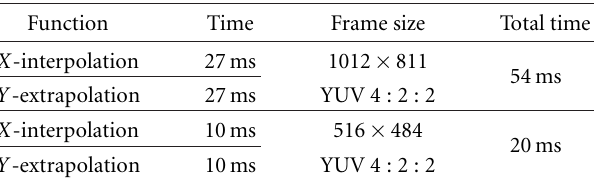
Table 1: The average time needed for the implementation based on the “one optimal uniform scale factor” idea on a Pentium III 550 MHz.